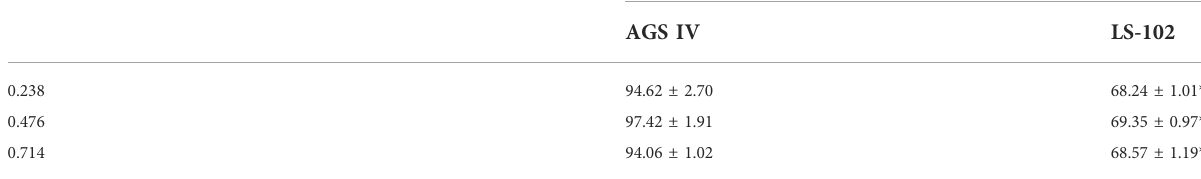
TABLE 1 The protein binding rates of AGS IV and LS-102 at different concentrations (n = 3). Concentration